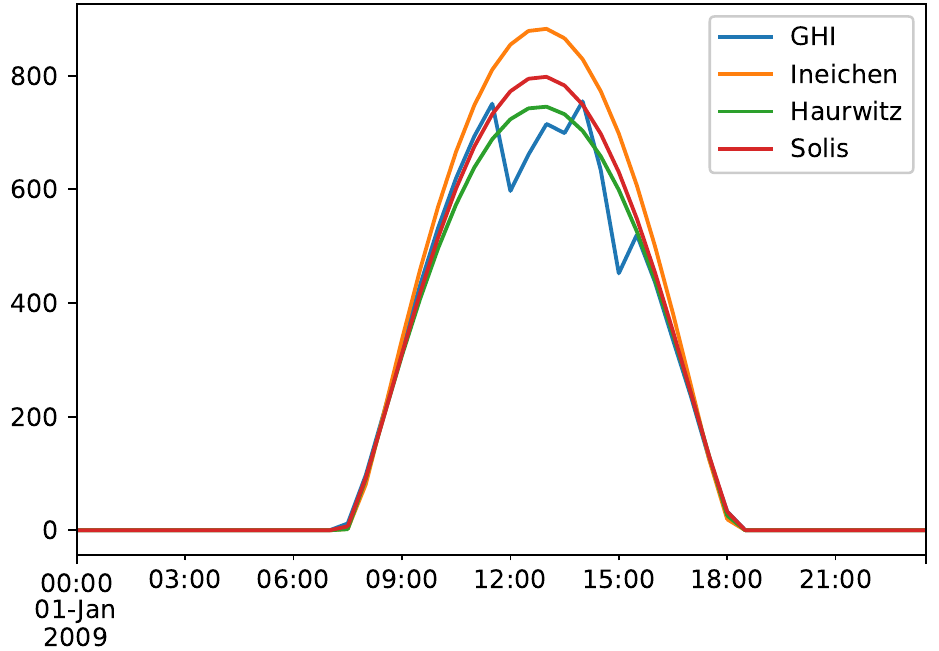
Figure 9. Observed GHI and clear-sky estimation for a particular